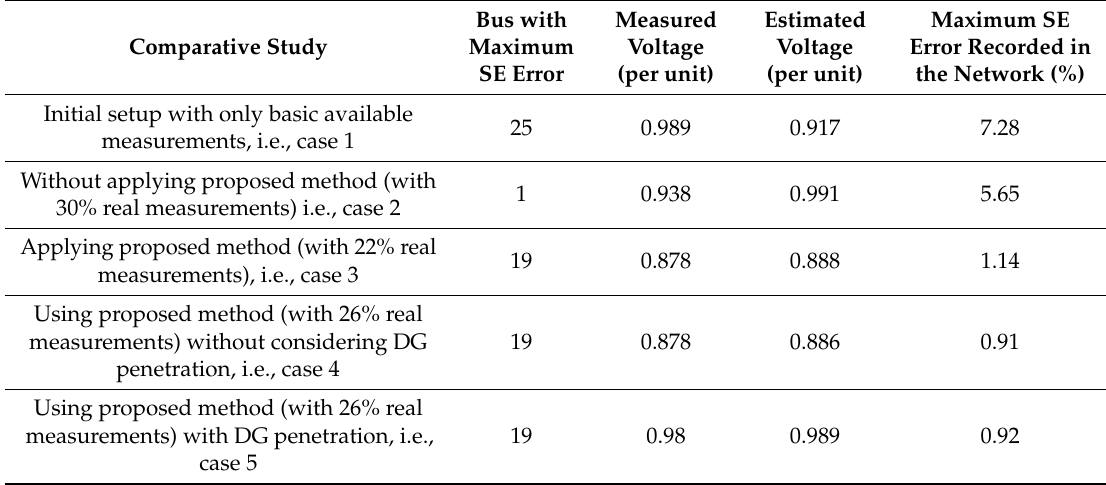
Table 2. Comparison of key